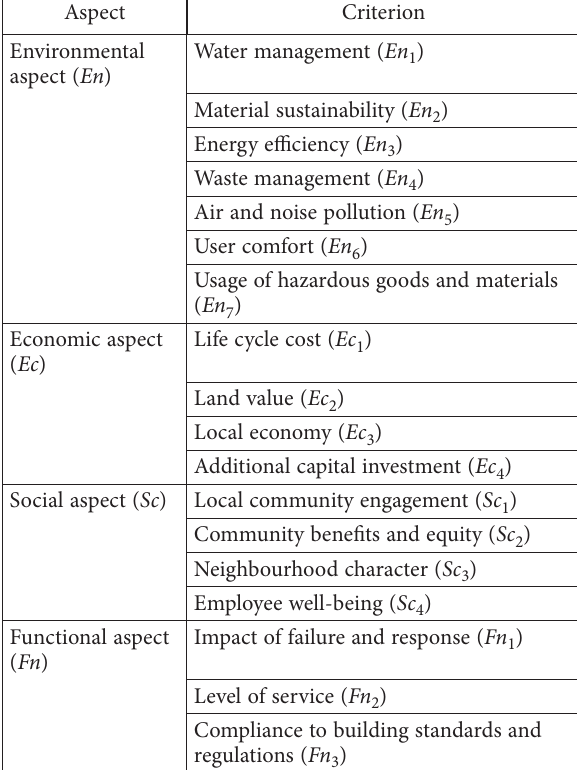
Table 3. Sustainability aspects and